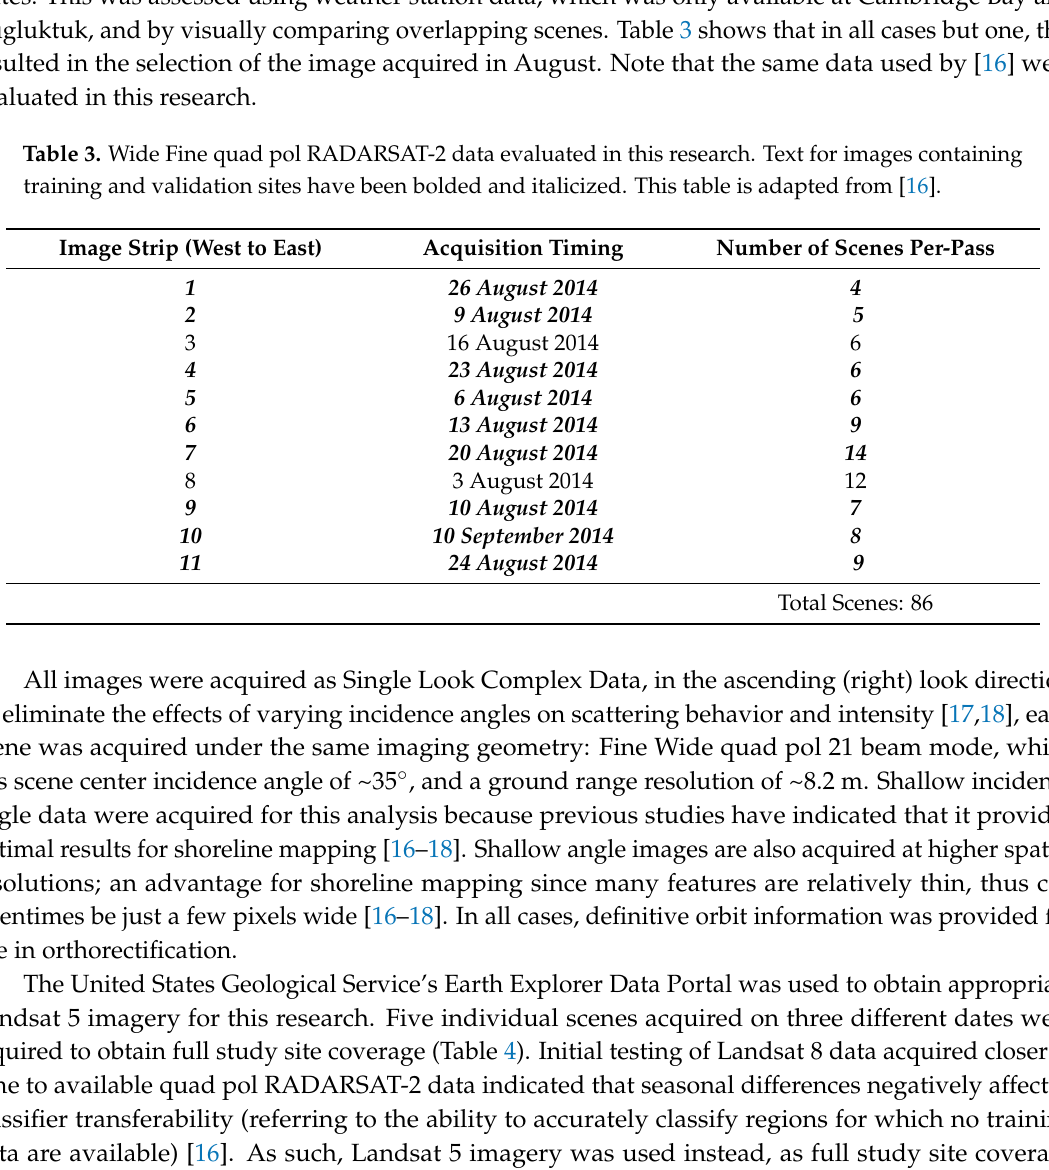
Table 3. Wide Fine quad pol RADARSAT-2 data evaluated in this research. Text for images containing training and validation sites have been bolded and italicized. This table is adapted from [16]. Image Strip (West to East) Acquisition Timing Number of Scenes Per-Pass 1 26 August 2014 4 2 9 August 2014 5 16 August 2014